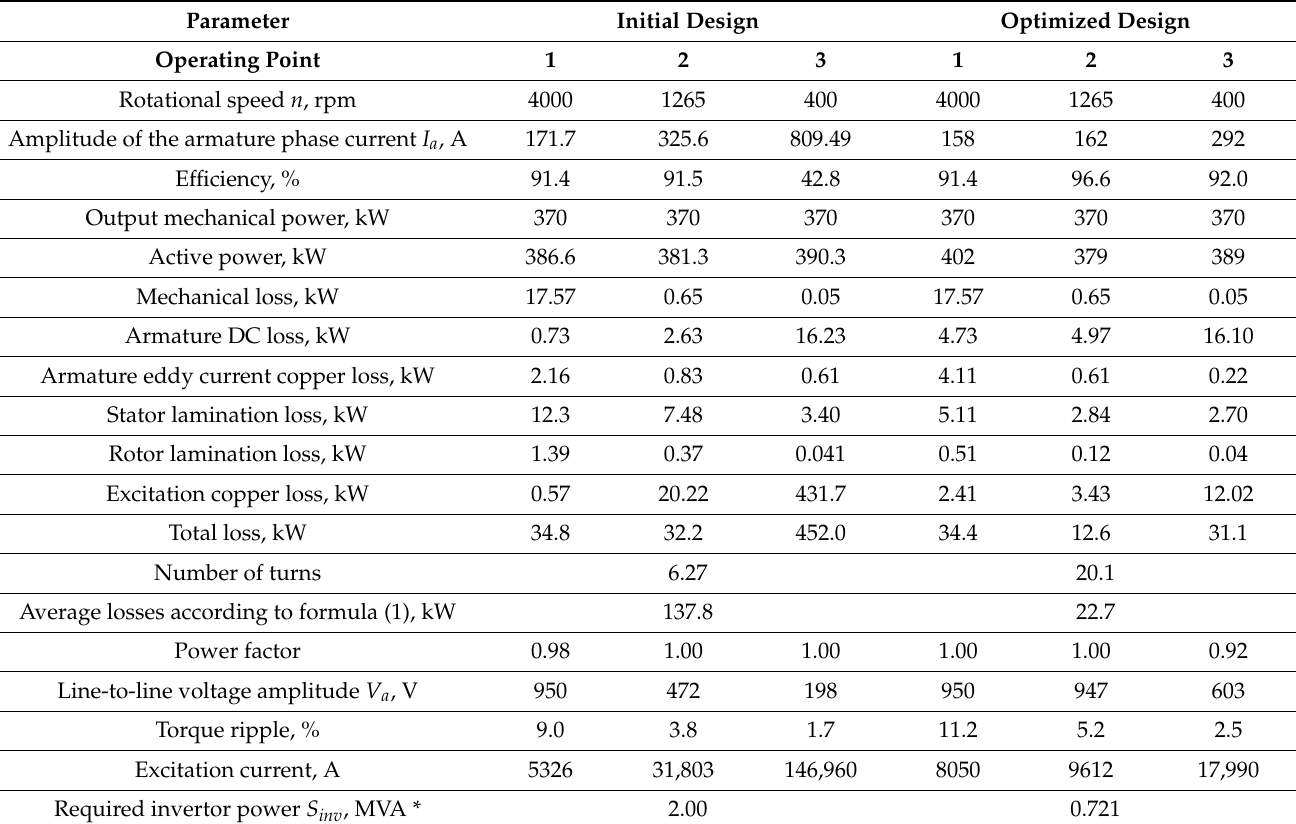
Table 4. Comparison of the WRSM characteristics before and after